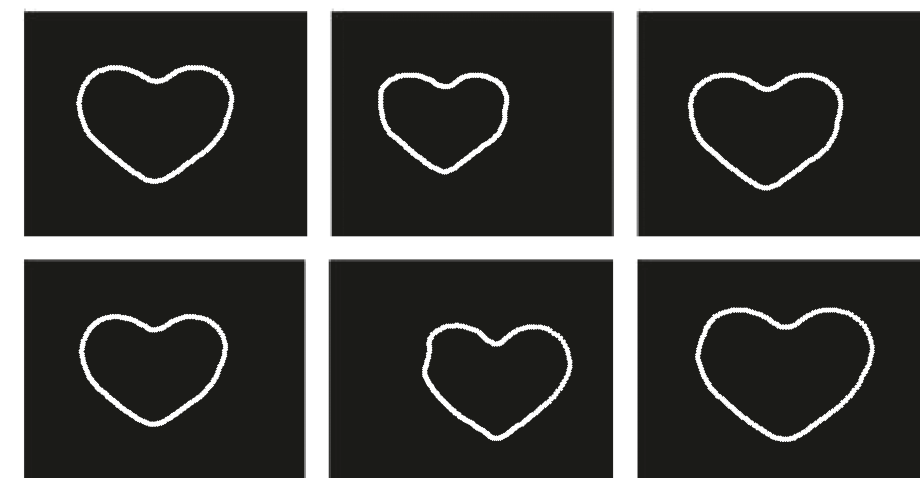
Figure 4: The shape prior.